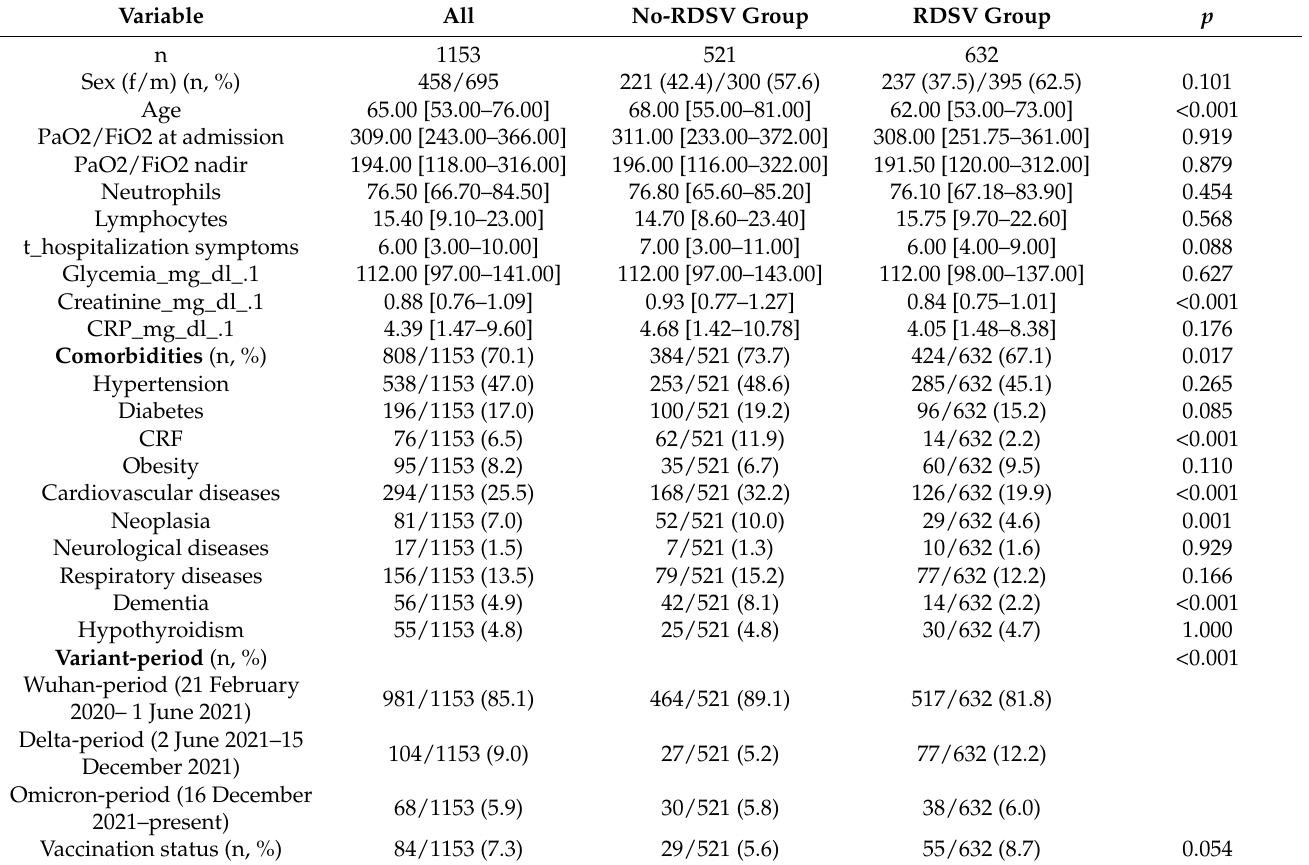
Table 1. Demographic and clinical characteristics of the study population.